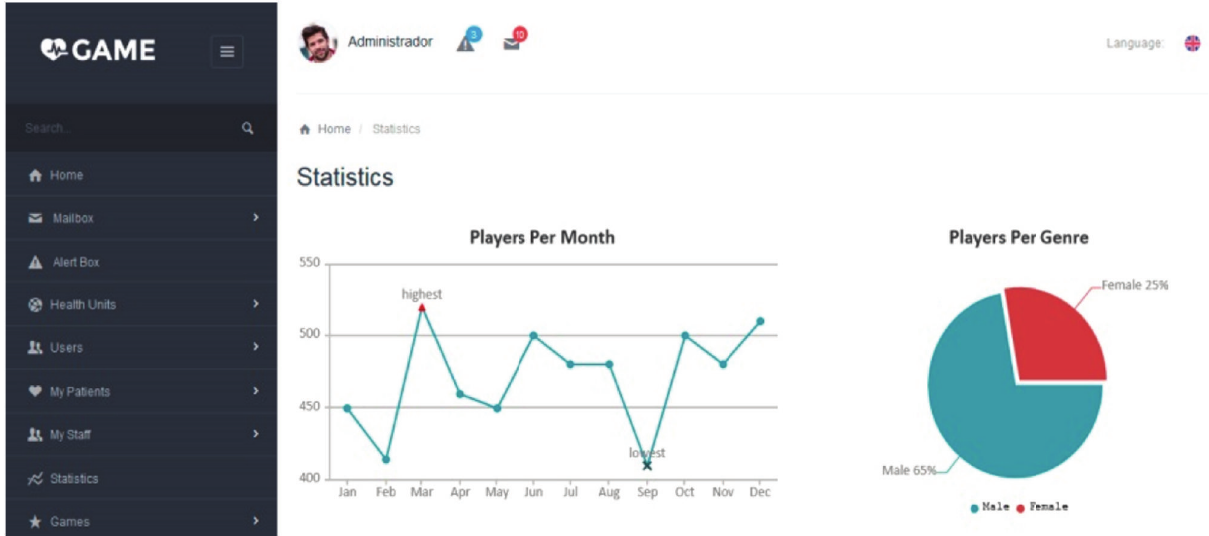
Figure 12: General statistics for